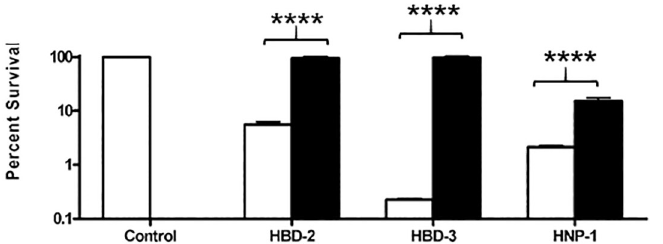
Fig 7. Exogenously added capsule reduces the bactericidal activity of human beta and alpha defensins against non-encapsulated B . anthracis . 20 μ g/ml HBD-2, HBD-3, or HNP-1 was pre-incubated alone or with 1 mg/ml capsule for 30 min at 37˚C before being added to non-encapsulated capA mutant bacilli in triplicate tubes. After incubation at 37˚C in 5% CO 2 for 2 h bacteria were plated for CFU. Control tubes without defensins were incubated and plated in parallel. Survival percentages were calculated by calculating the ratio of CFU with/CFU without defensin. Three experiments were run (n = 3). Results expressed as the mean + SEM from a representative experiment are shown. Black bars represent samples where capsule was pre-incubated with the defensin and the white bars represent defensins alone. Significance of differences in survival with and without capsule was determined by two-tailed Student’s t-test ( ���� p <